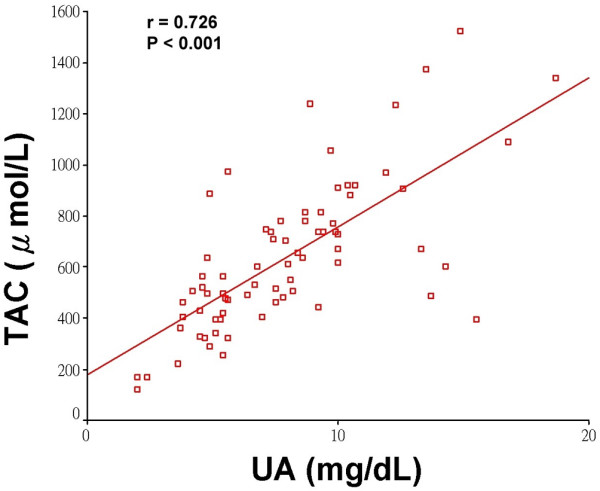
Correlation between serum TAC and UA in patients with severe sepsis. A total of 73 patients were included in the study. TAC, total antioxidant capacity; UA, uric acid.